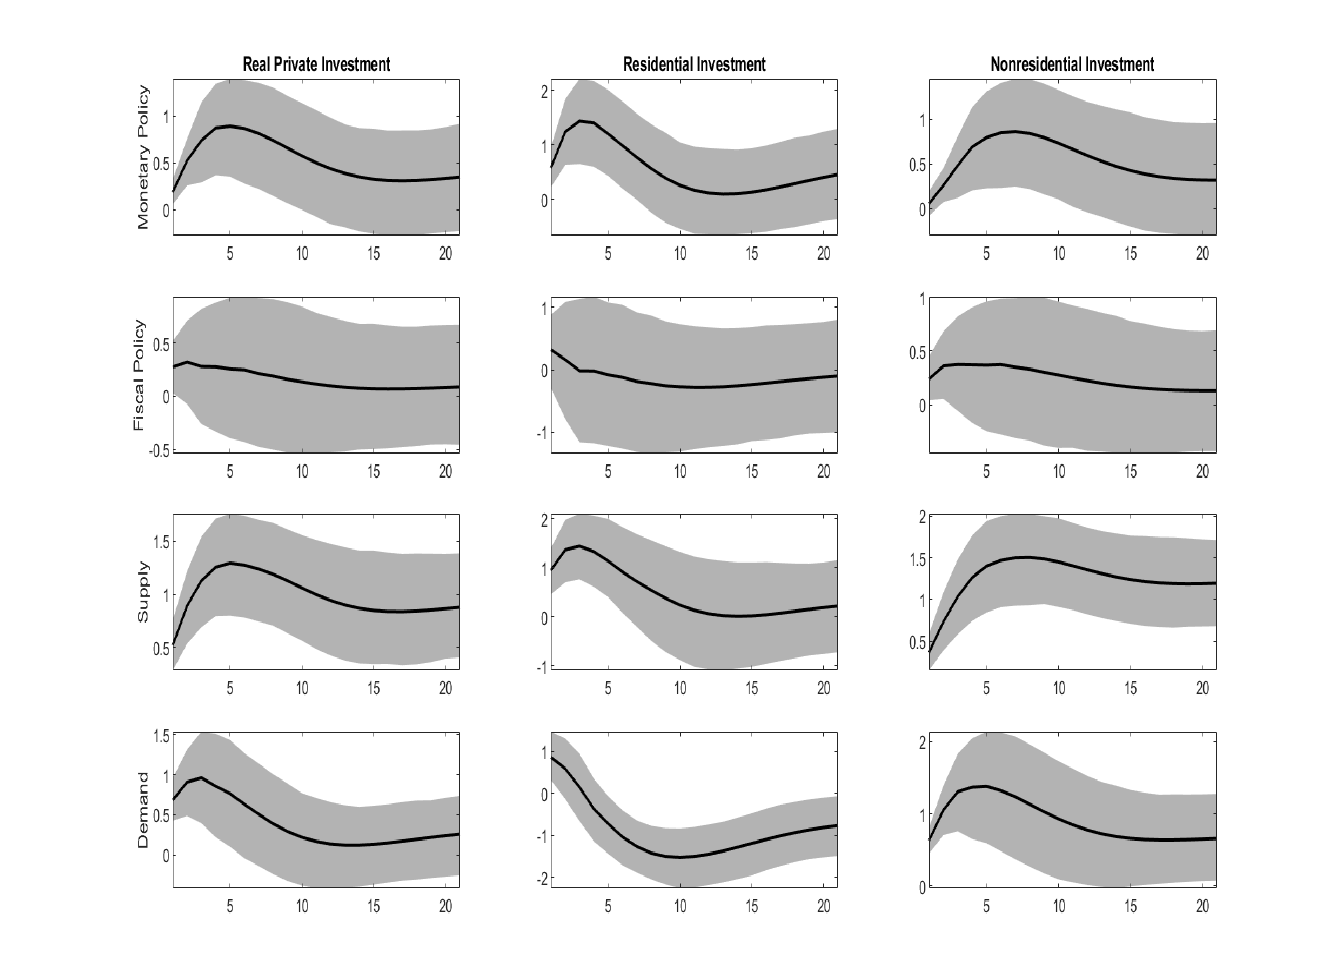
Figure 4. Impulse-response functions. Solid line point estimate, gray areas 68% confidence